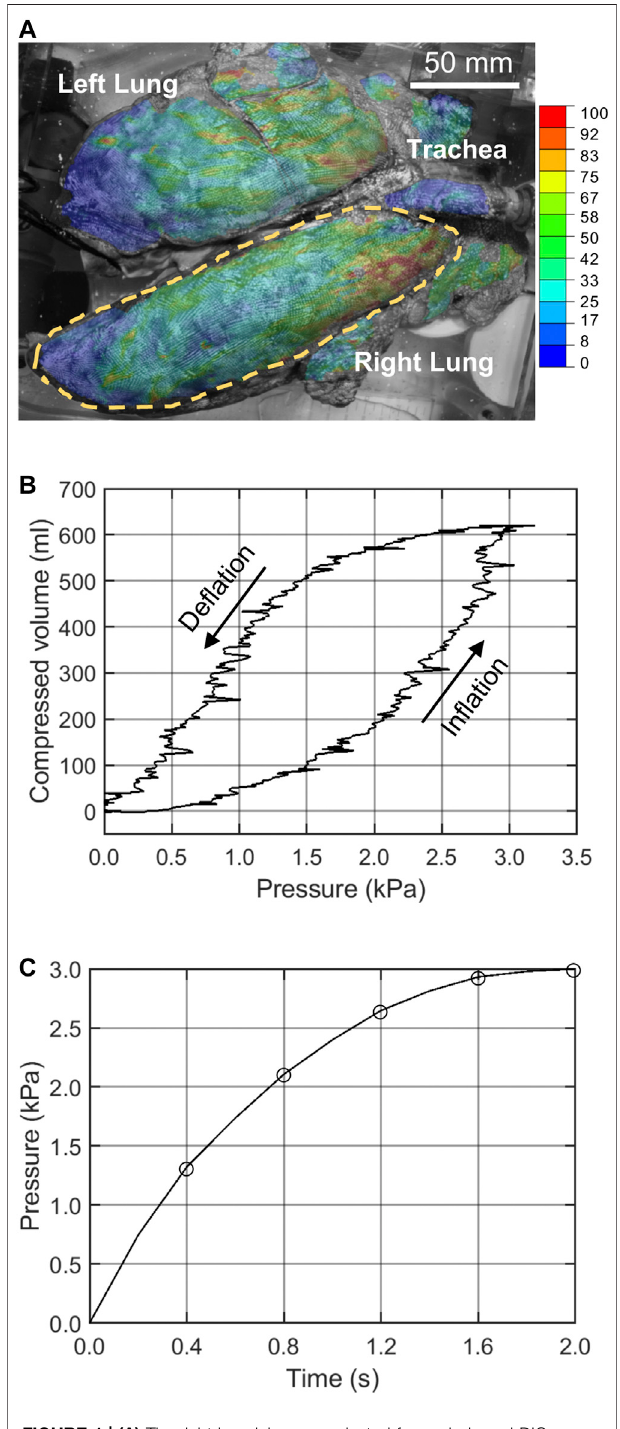
FIGURE 1 | (A) The right lung lobe was selected for analysis and DIC strains are shown. (B) The pressure-volume data of the stabilized in fl ation cycle was used to extract the (C) pressure-time data applied to the FE